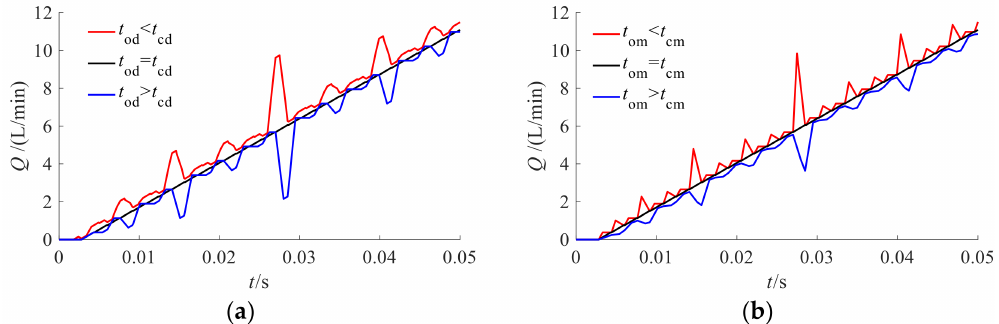
Figure 5. Analysis of the transient flow uncertainty of BDVA: ( a ) Asymmetry of delay time; ( b ) Asym- metry of movement time.